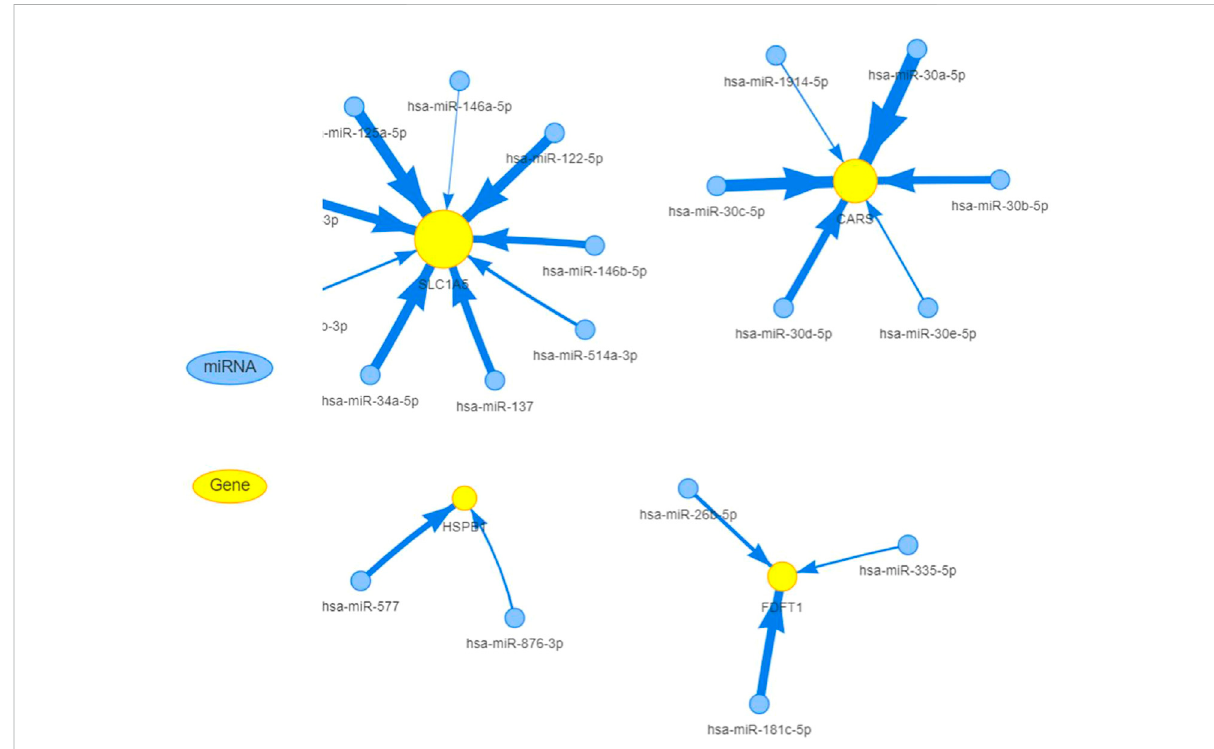
FIGURE 4 MiRNAs target FGRs in colon cancer. FGRs can be controlled by miRNAs in